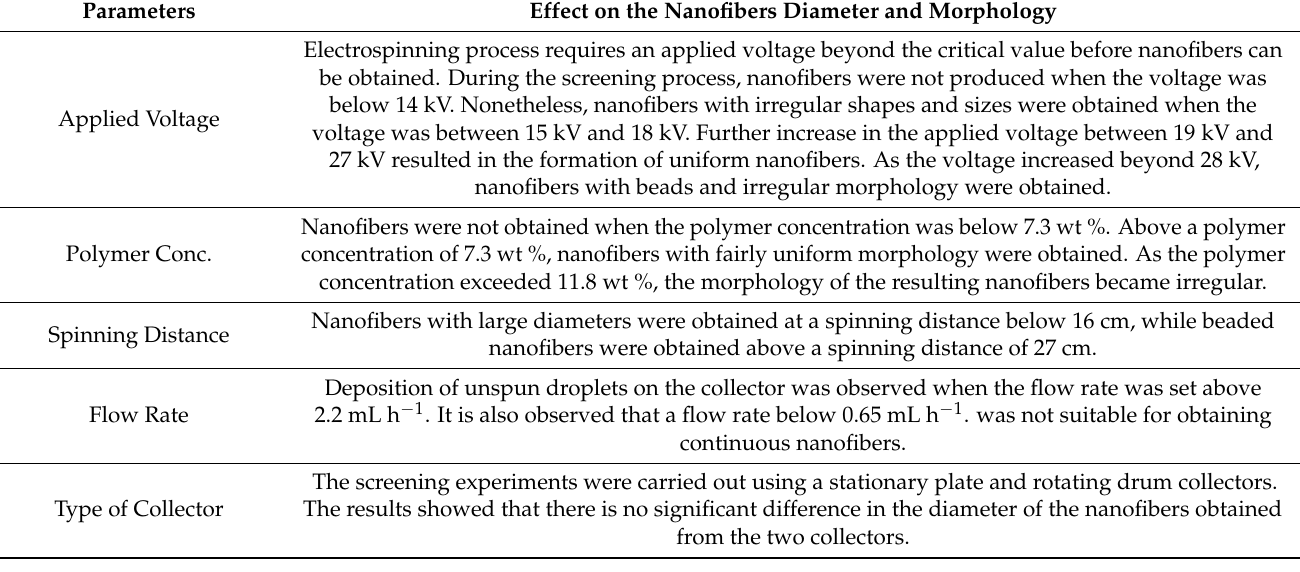
Table 1. Summary of the preliminary investigation results.